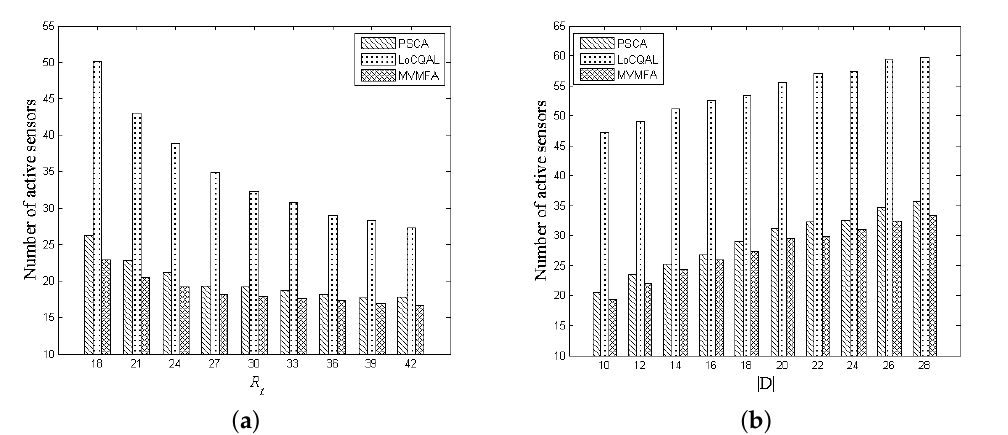
Figure 10. Performance of PSCA, the localized coverage quality algorithm (LoCQAL) and MVMFA with different R t ( a ) and | D | ( b